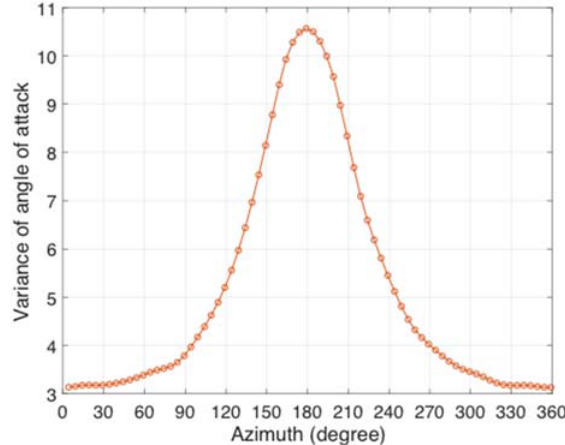
Figure 10. Snapshot of vorticity iso ‐ surfaces, coloured according to 𝑧 ‐ component.